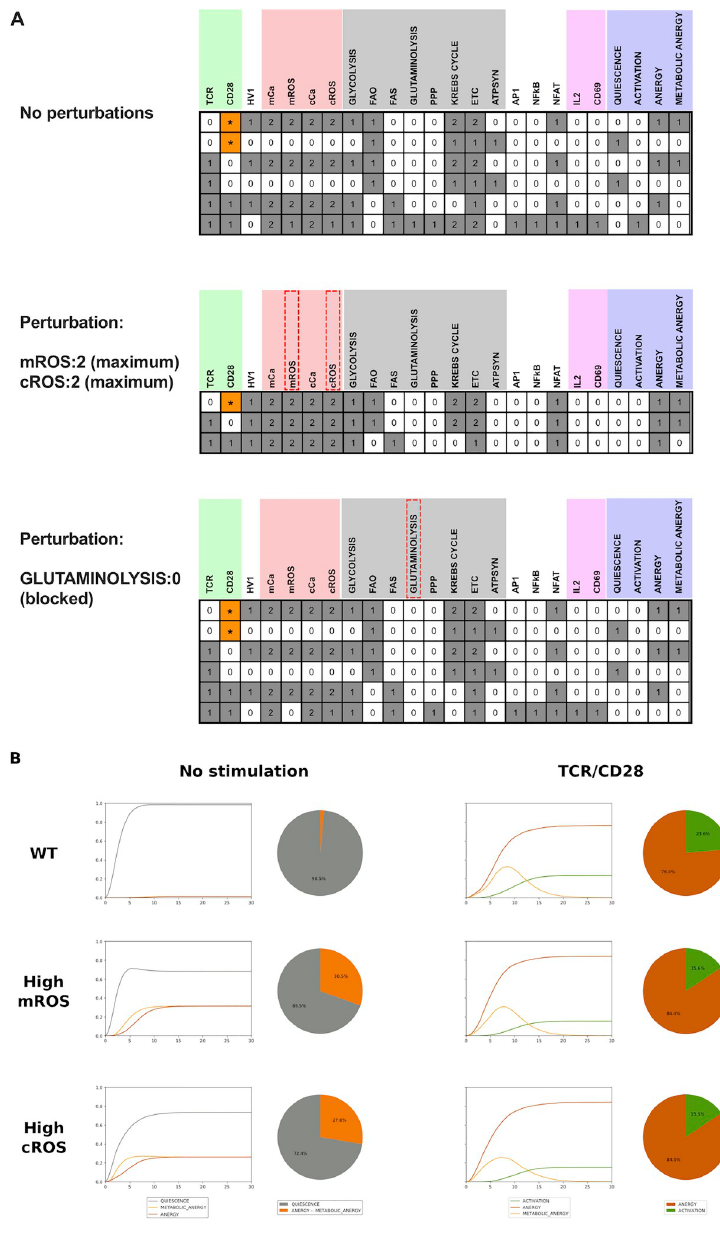
Fig 4. The analysis of the logical model recapitulates the impact of metabolism on T cell activation. (A) Computation of the stable states on selected nodes of the model in three different scenarios (No perturbation; mROS: 2 or cROS: 2 and GLUTAMINOLYSIS: 0). Each row represents a single stable state. For each node, the white cells (0) denote the lowest functional levels, while the gray cells denote intermediate (1) or maximum (2) levels of activity. We further used the MaBoSS software to evaluate the reachability of the different phenotype nodes in the absence of stimulation or upon TCR/CD28 stimulation (B). The pie charts represent the frequency of each phenotype under each condition, while the time plots represent the evolution of each phenotype node over